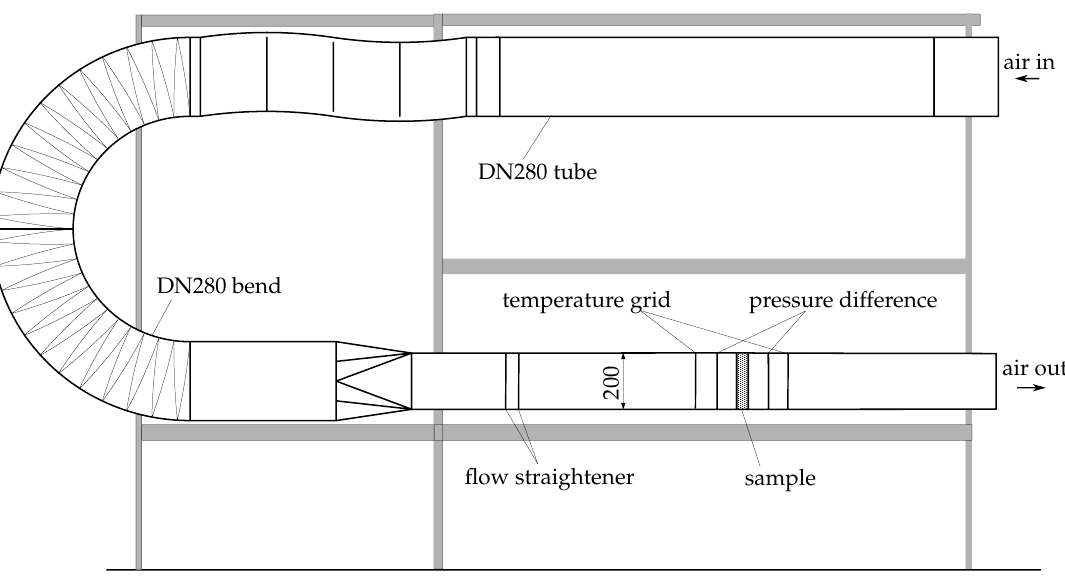
Figure 5. Schematic of the test